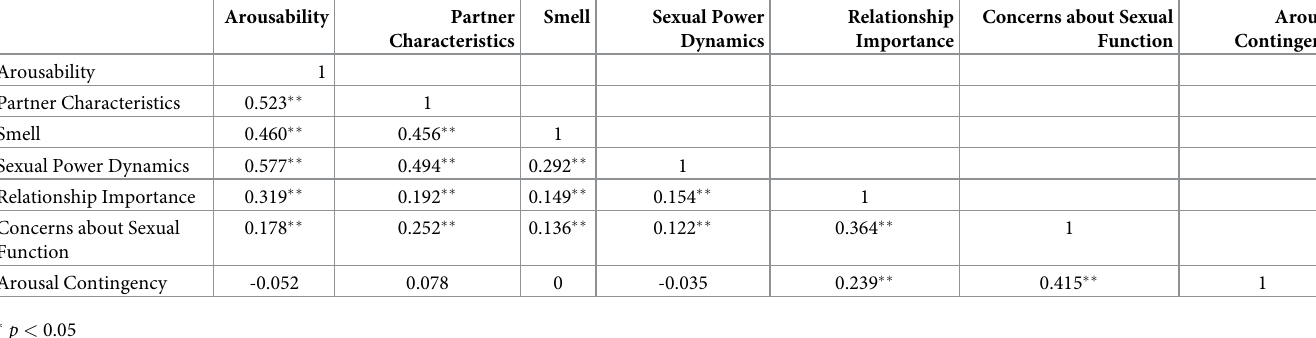
Table 4. Interrelation between SESII-W-PL subscales (Pearson’s r correlations).